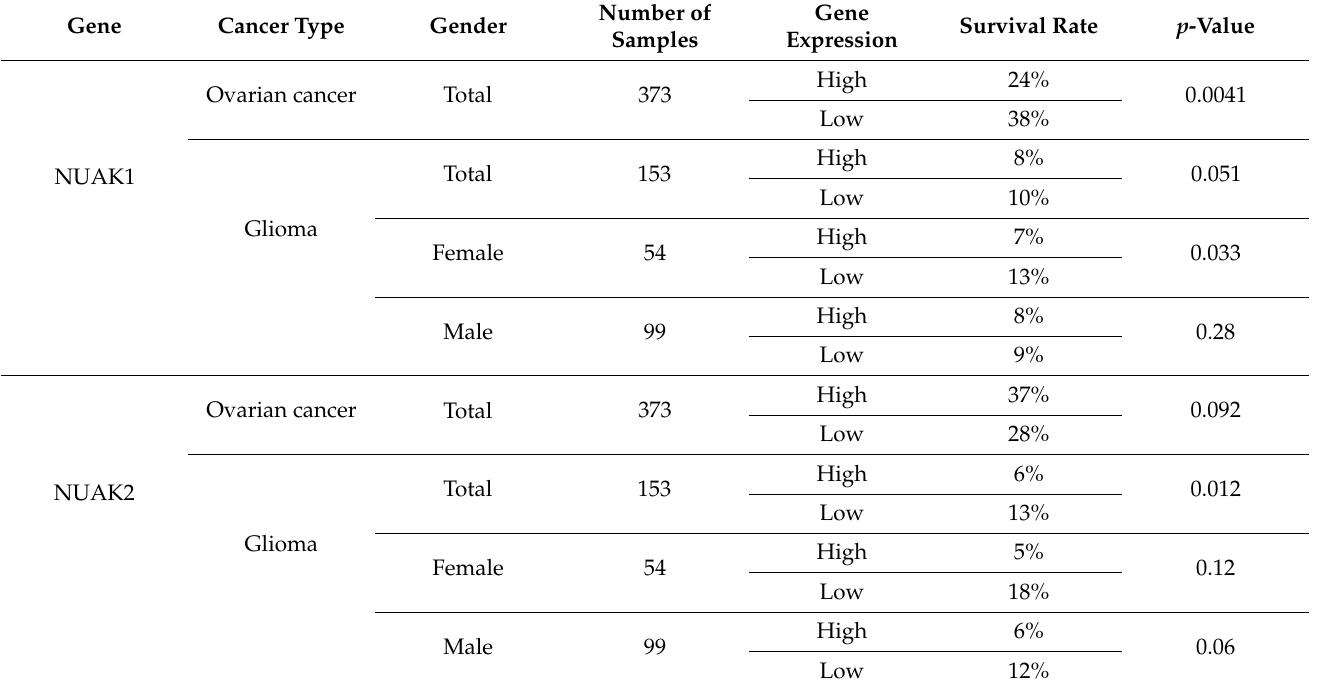
Figure 5. NUAK1 and NUAK2 alterations in different brain cancer tumors. cBioportal database data of NUAK1 and NUAK2 alterations in different brain cancer tumors from 19 different studies of human patient samples. From a total of 1102 patient samples, NUAK1 was altered in 0.6%. Alterations included amplifications, deletions, or mutations. In NUAK2, overall amplifications were detected in 1.7% of these patient samples. Table 2. Protein Atlas data from patient samples. Survival rate data analysis in ovarian cancer and